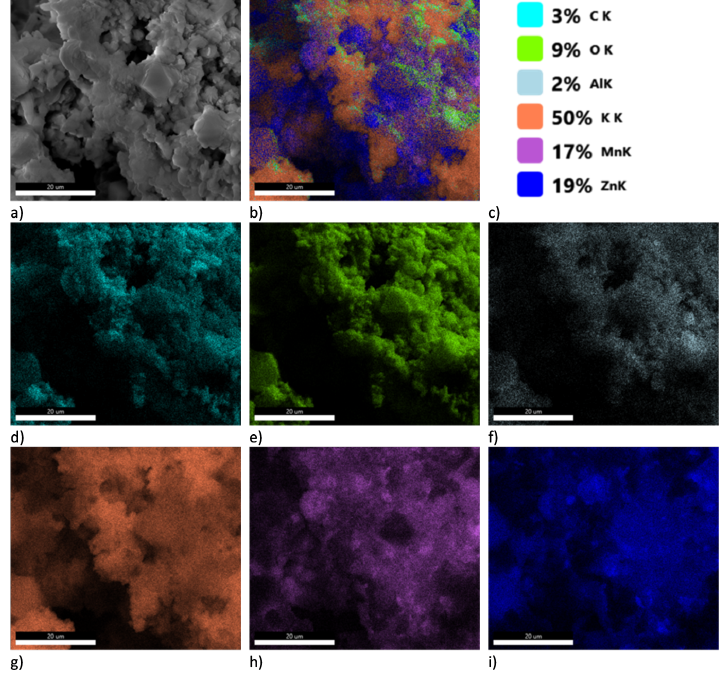
Figure A3. Result of SEM-EDS analysis for sample Zn3. ( a )—SEM picture; ( b )—EDS map; ( c )— weight concentration %; ( d )—EDS map for C; ( e )—EDS map for O; ( f )—EDS map for Al; ( g )—EDS map for K; ( h )—EDS map for Mn; ( i )—EDS map for Zn.